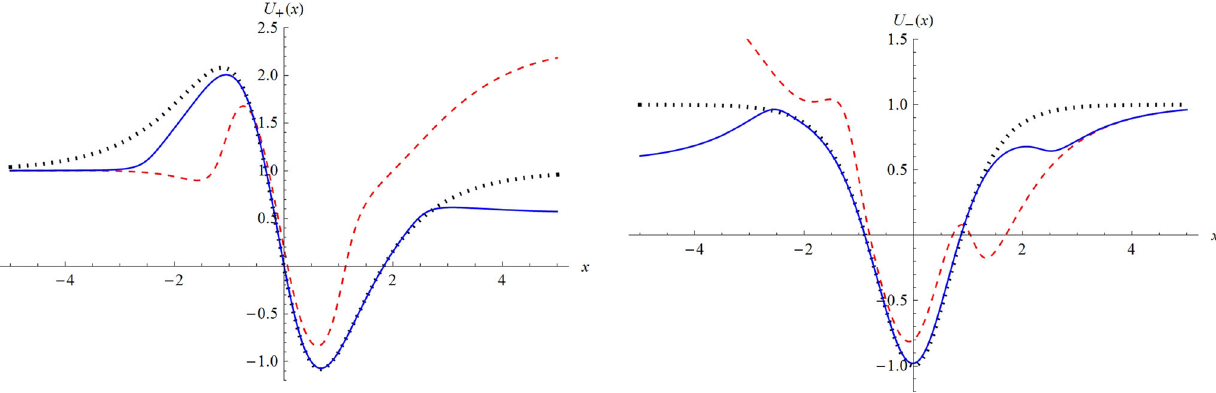
Fig. 10 Quantum-mechanical potentials U + (on the left) and U − (on the right) for a 2 = 0 and b 3 = 0 (dotted line), a 2 = 0 . 01 and b 3 = 0 . 01 (solid line), and a 2 = 0 . 1 and b 3 = 0 . 1 (dashed